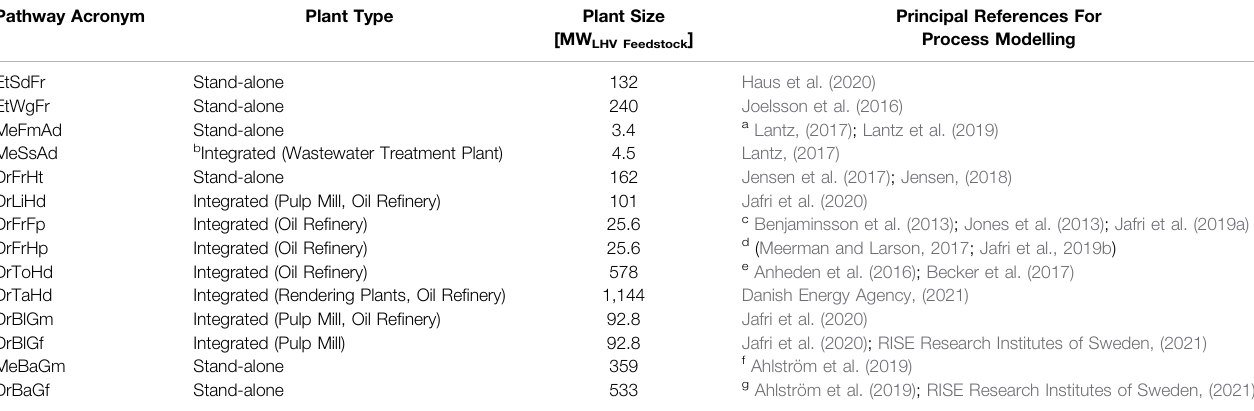
TABLE 2 | Principal references for biofuel pathway process